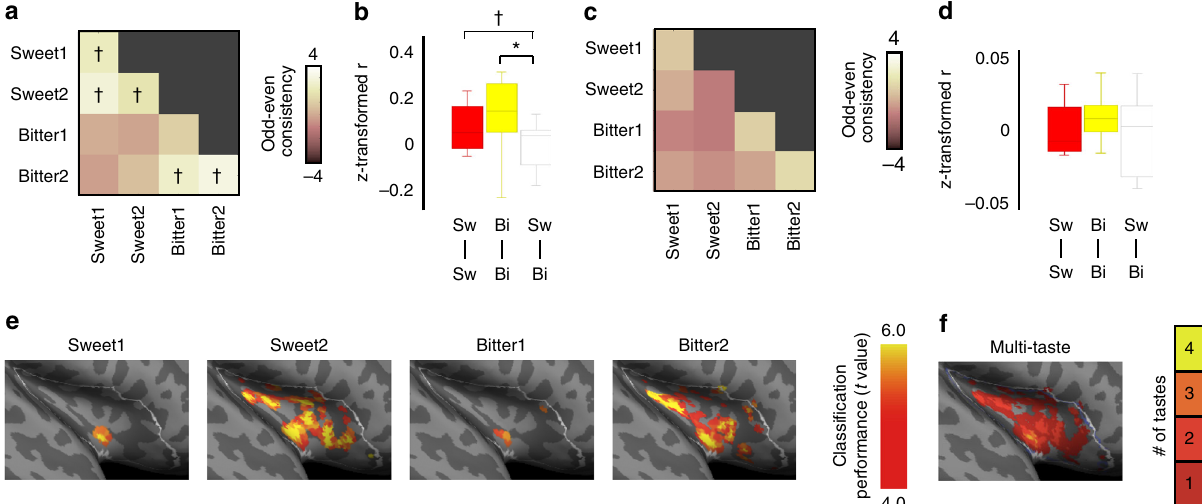
Fig. 4 Speci fi city of taste quality not chemical compound in the insula under super-high fi eld strength. a Correlations of voxel activation between odd and even runs between all taste combinations within each participant, submitted to one-sample t -test across participants ( n = 11 participants). Statistically signi fi cant correlations within taste types but not across taste types suggest voxel-speci fi c tuning at the individual level. b Correlations between odd and even runs for each same taste and different taste combinations in a show within-taste-type correspondence. Boxes represent the median and 25th/75th percentiles and whiskers represent the minimum and maximum. c The same correlations in a computed for voxels de fi ned by group-level sensitivity to taste stimuli for each subject in a leave-one-out procedure. One-sample t -test across participants showed no taste speci fi city at the group level. d Correlations between odd and even runs for each same taste and different taste combinations in c reiterate lack of group-level taste speci fi city. Boxes represent the median and 25th/75th percentiles and whiskers represent the minimum and maximum. e Multivoxel pattern analysis shows group-level discriminability maps for sweet 1, sweet 2, bitter 1, and bitter 2 stimuli. f The number of taste stimuli represented in the insula. This replicates multi-taste population codes representing and discriminating multiple tastes in the anterior/middle insula as is shown in Fig. 2b. ✝ p < 0.05 uncorrected, * p < 0.05 after Bonferroni correction for multiple comparisons (FWE < a common hedonic scale, aligned with more abstract emotional experiences, such as disgust 2, 38 and delight 1 . The convergence of individual gustatory maps of basic taste qualities into a multi- taste code, in conjunction with other modalities such as smell and texture, may support the complex experiences of palatability and fl avor.